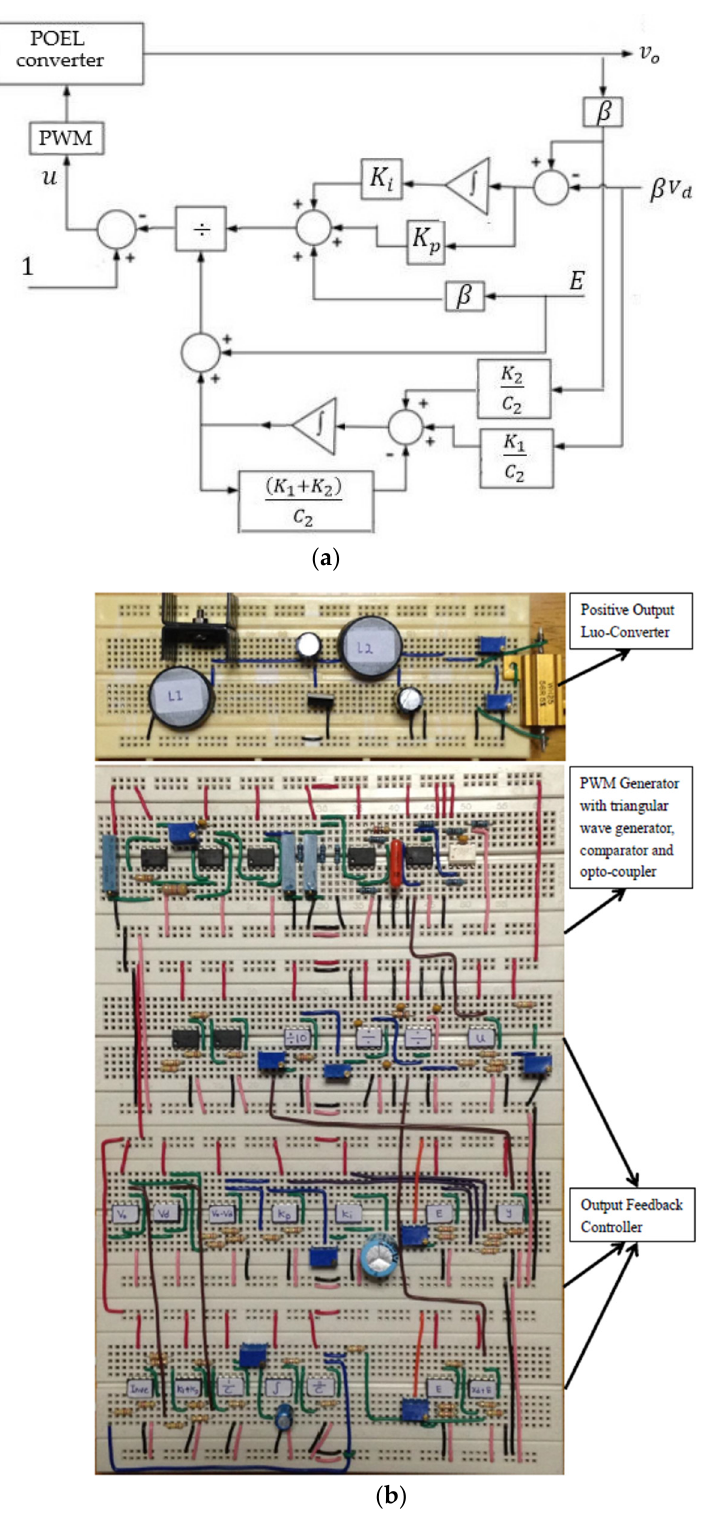
Figure 7. Control schemes for POEL converter. ( a ) Block diagram of voltage-based feedback controller; ( b ) Experimental